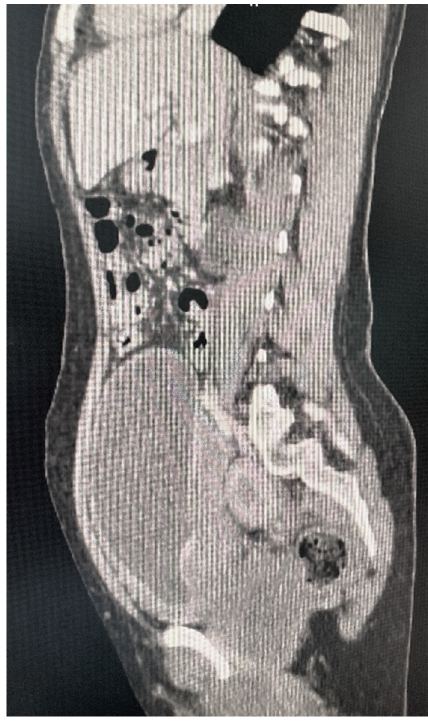
Figure 4. Uro-CT–lateral view.